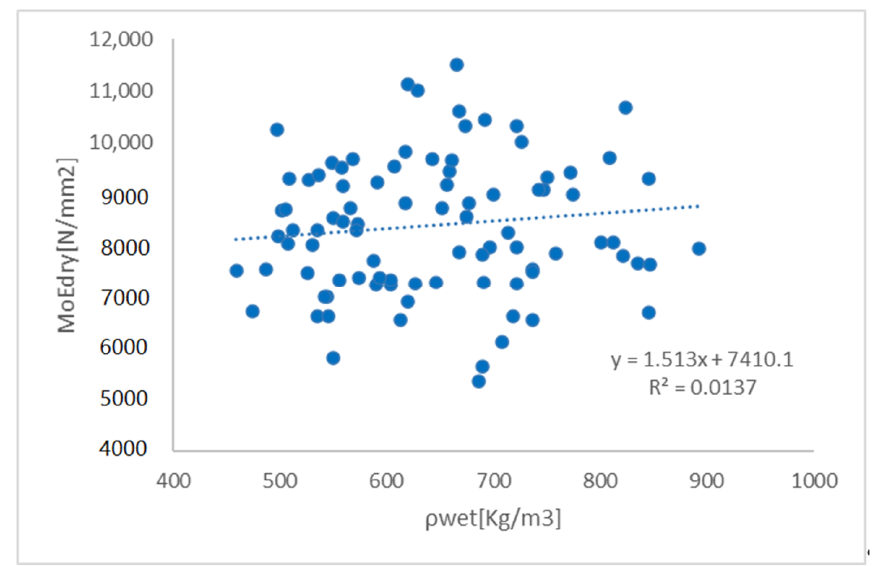
Figure 12. MoE wet vs. MoE dry .